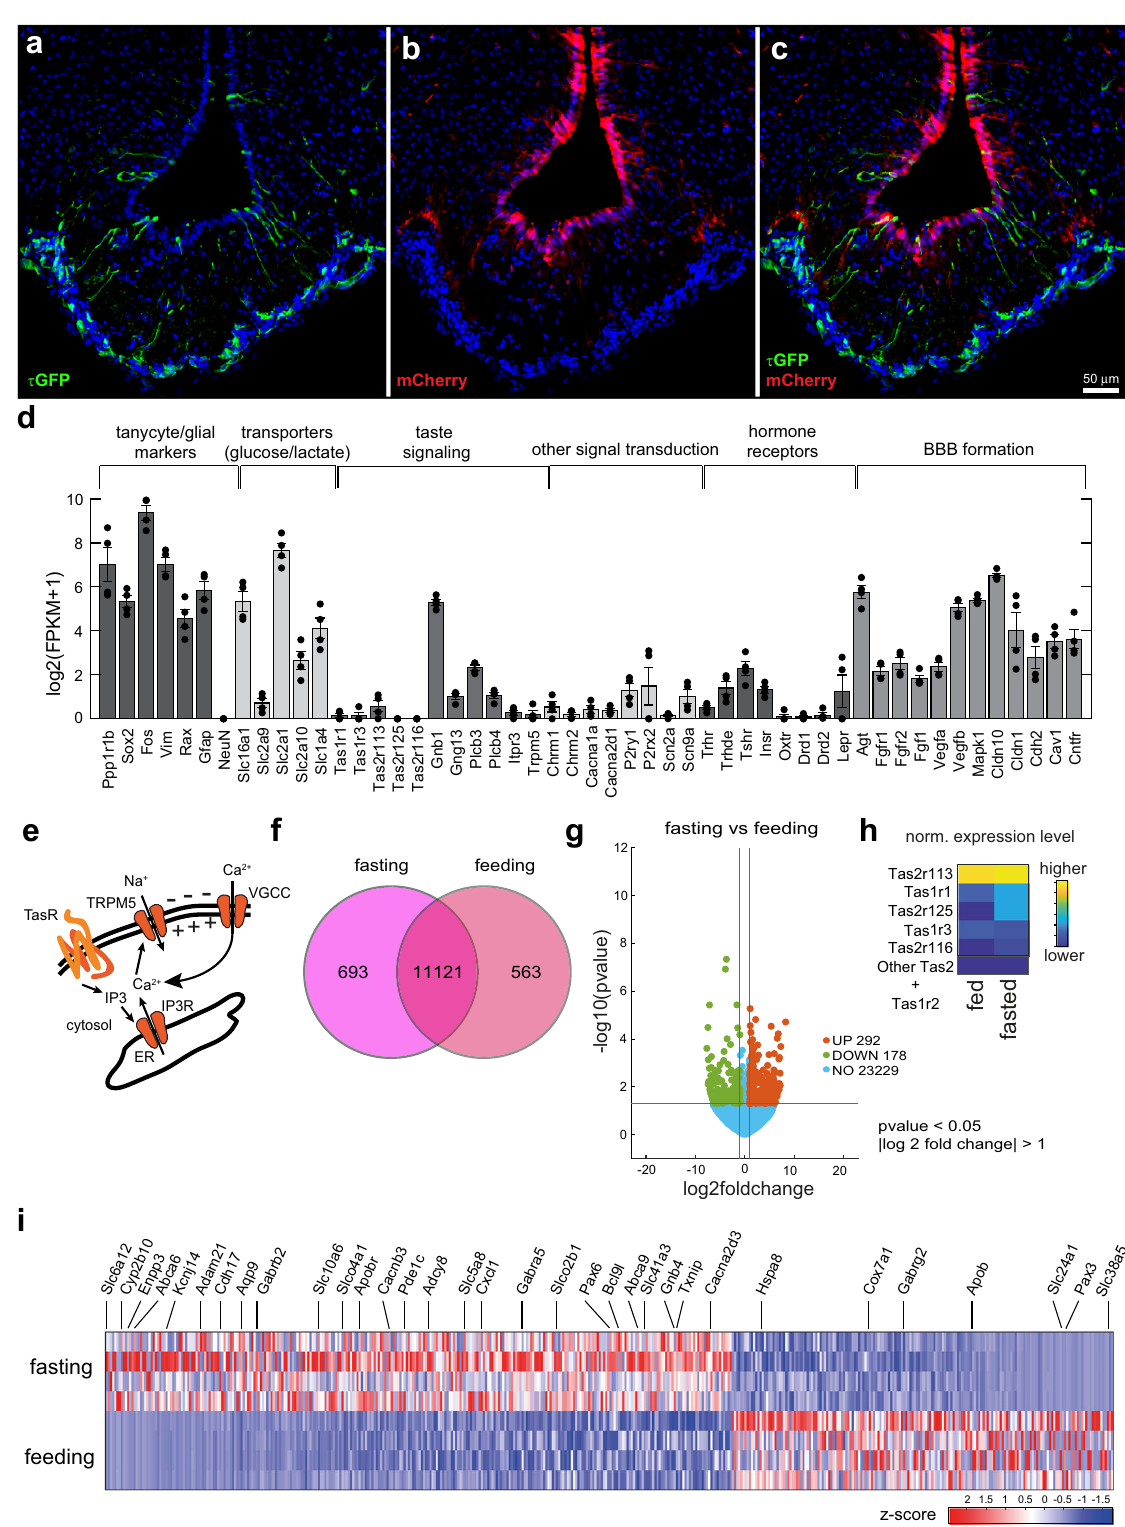
Fig.3|Expressionpro fi lingofM5tanycytes.a – c AAV2/1+2-CAGS-mCherryvirus wasinjectedthreeweeksbeforeFACSsortingofM5tanycytes( n =3).Expressionof GFP in M5 tanycytes and pars tuberalis cells a and mCherry in tanycytes b before FACSsorting. c NotethecolocalizationofGFPandmCherryintheM5tanycytesbut not in the pars tuberalis . d Genes expressed in M5 tanycytes involved in different signaling pathways by RNA-seq (bar plot represents mean±SEM from n =4 dif- ferent samples, individual log values shown for each gene). e Model indicates M5 activation after TasR activation. VGCC: voltage-gated calcium channels. f Venn